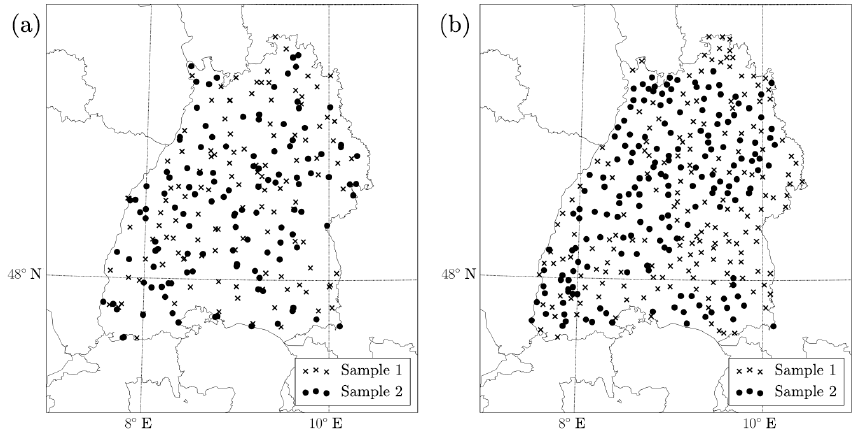
Figure 7. The locations of the two 2-fold cross-validation samples for the sub-daily (a) and daily gauges (b) .